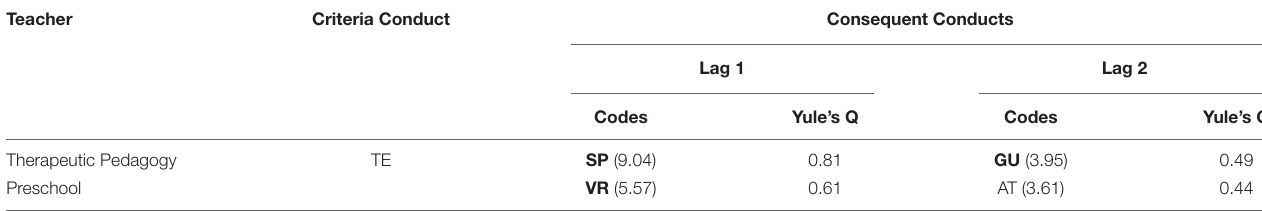
TABLE 7 | Teacher’s Communicability Function.